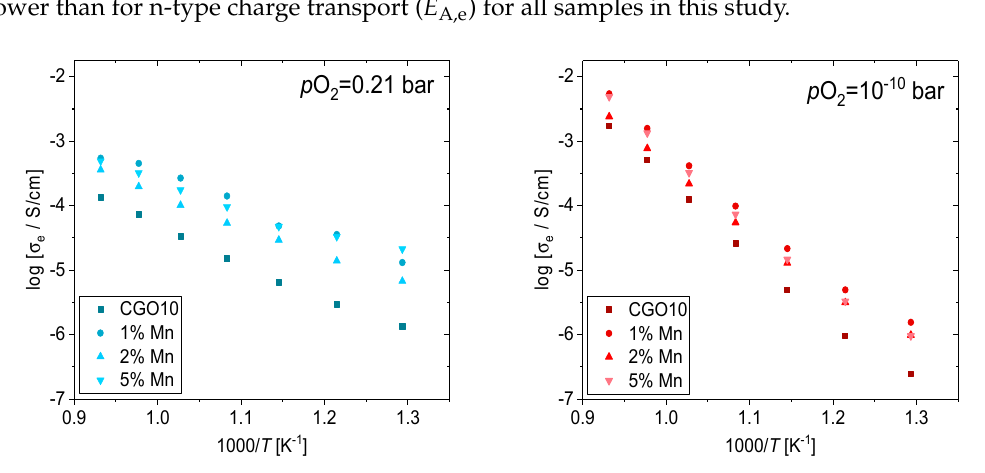
Figure 8. Electronic conductivity at p O 2 = 0.21 bar (blue symbols) and at p O 2 = 10 − 10 bar (red symbols) for the respective compositions. A list of activation energies for electronic transport at these partial pressures can be found in Table 2.